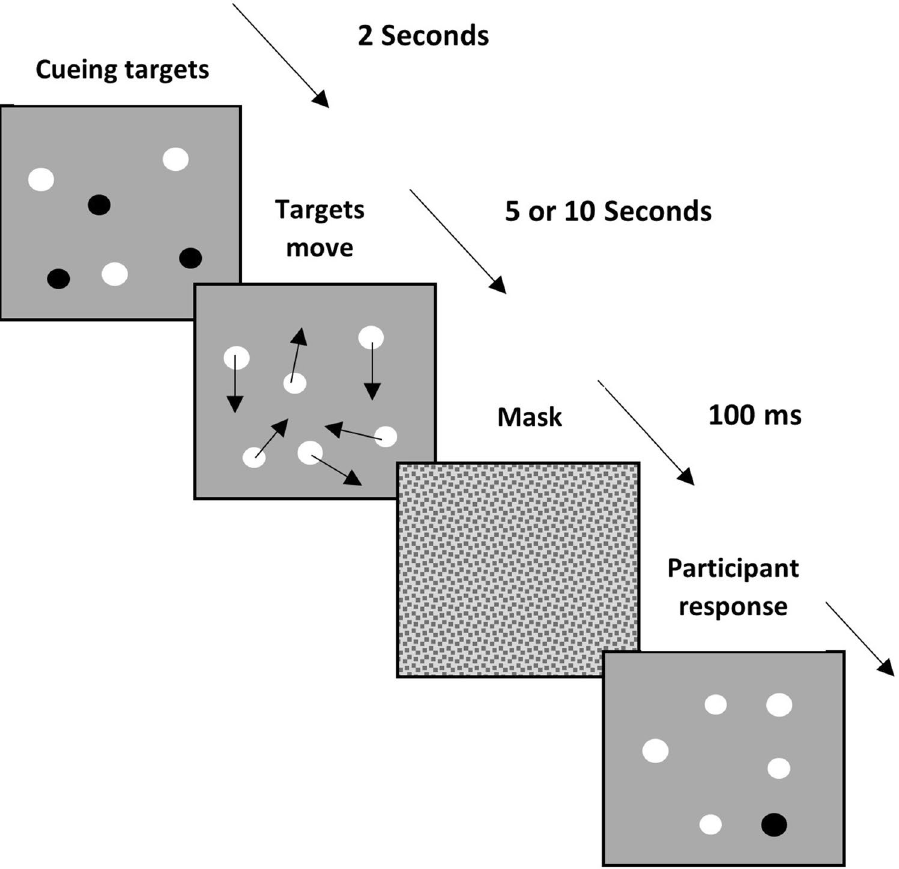
Figure 1. A schematic diagram of multiple objects tracking task used in the present study. Initially, target dots were cued and after a brief delay period, all dots moved randomly for a fixed period of time of 5 or 10 s. At the end of this period, a mask was quickly shown before one of the dots was cued and the participants were required to judge whether it was a target dot.